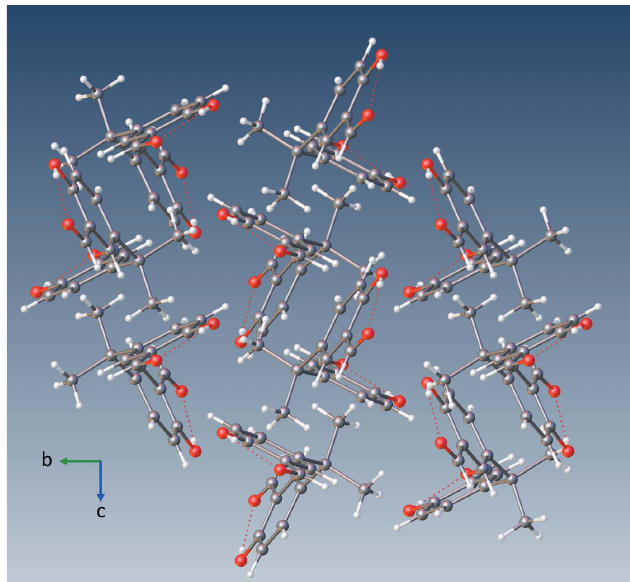
Figure 3 Crystal packing of ( 1 ) along the a axis. Red dashed lines show the intramolecular O—H (cid:3)(cid:3)(cid:3) O hydrogen bonds.